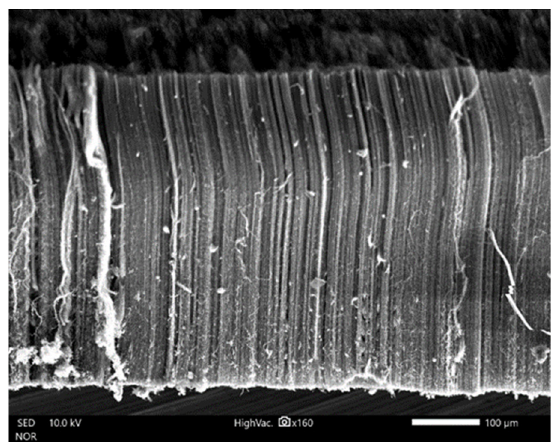
Figure 1. Carbon nanotubes in form of the “carpet”—raw material from synthesis.